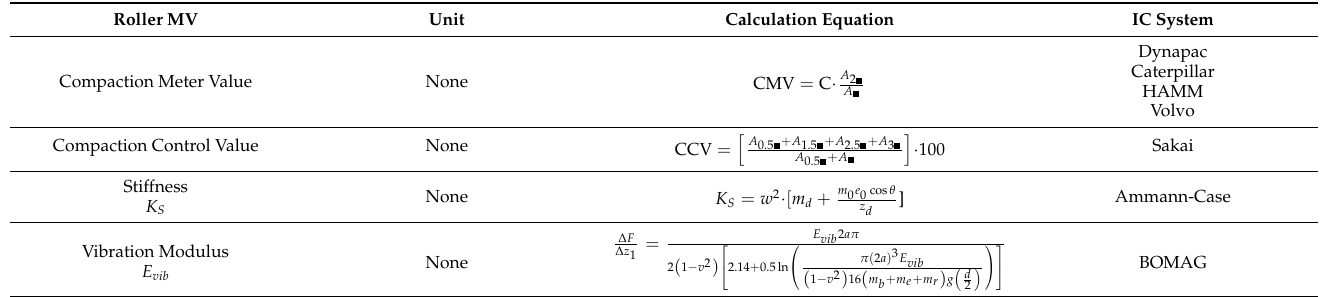
Table 2. IC roller compaction measurement